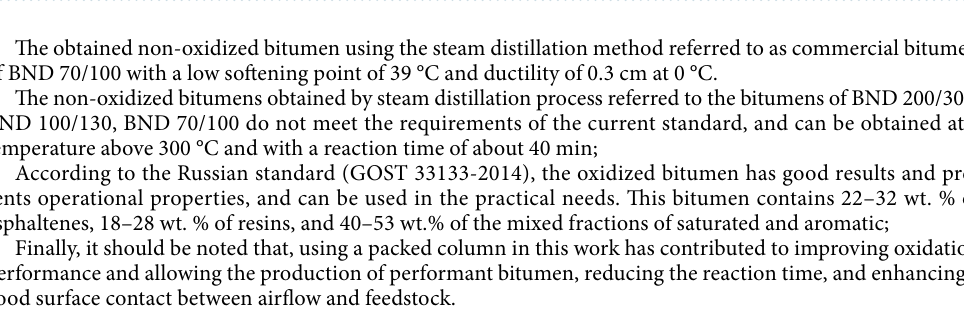
Figure 4. Schematic of the pilot apparatus for steam distillation of heavy